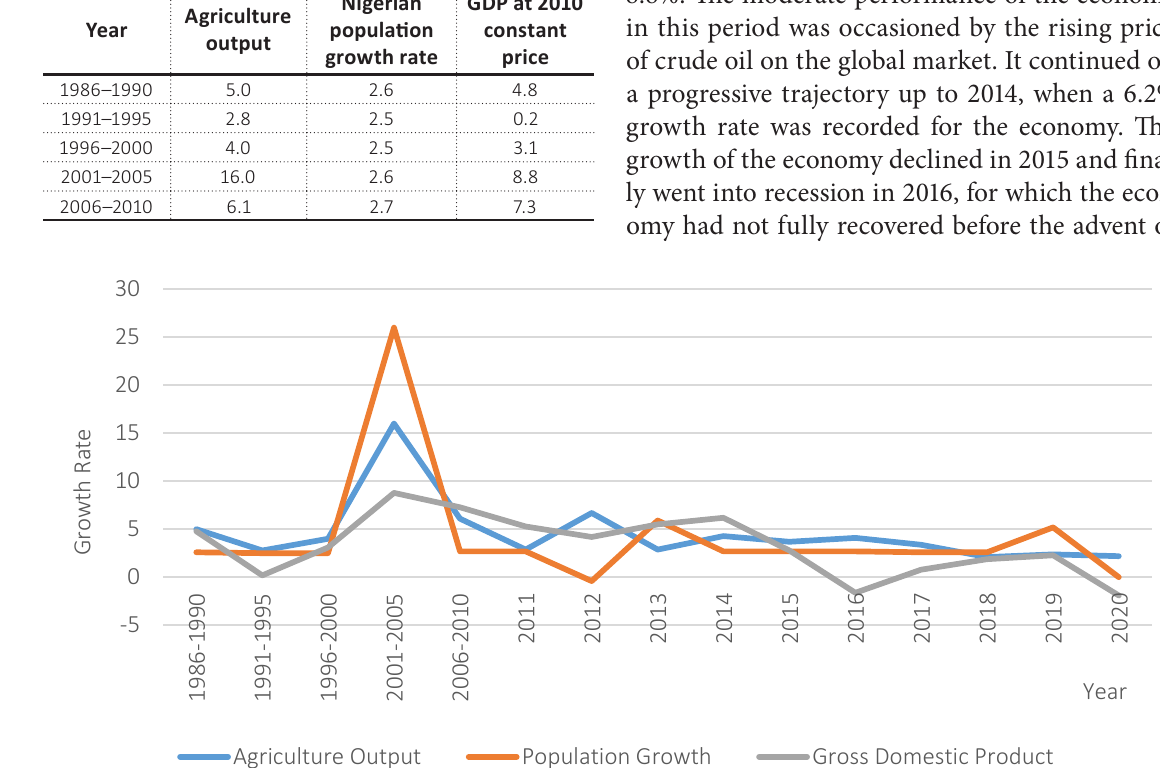
Table 1. Structure of food security and population growth in Nigeria (%)